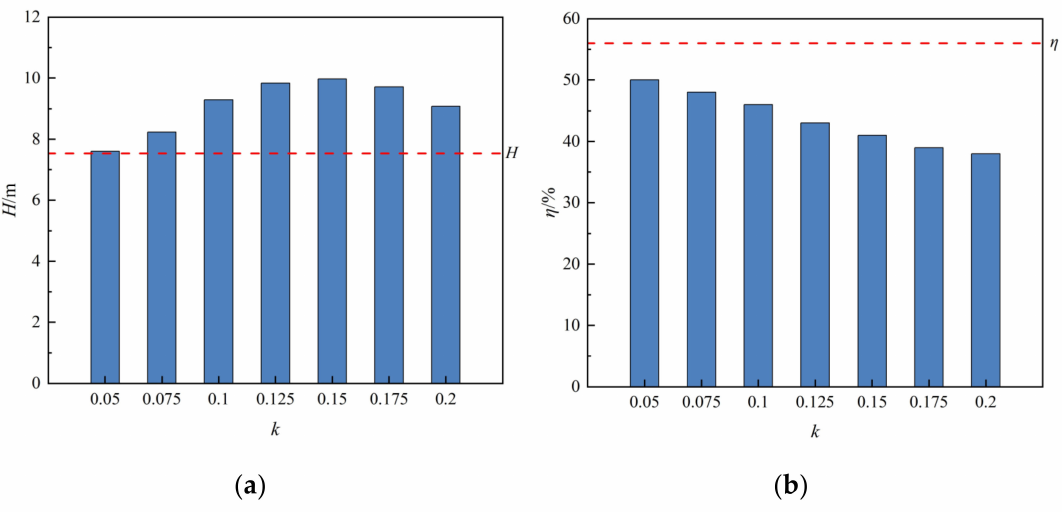
Figure 7. Comparison of external characteristic under different radial height. ( a ) Head, ( b )